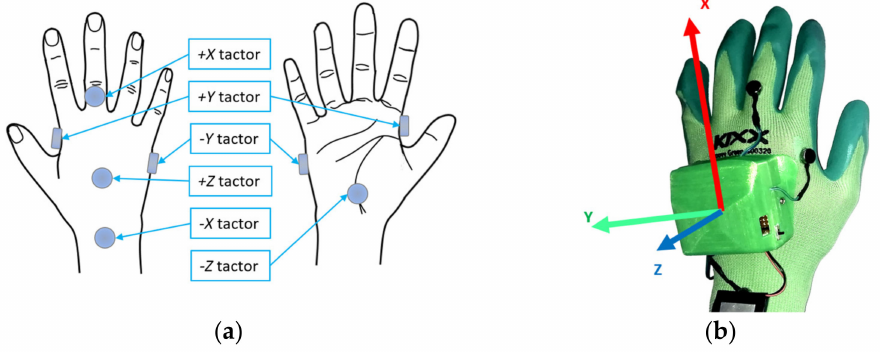
Figure 5. Tactors placement around the hand: ( a ) function of each tactor (positive and negative directions of X, Y, Z axes); ( b ) spatial organisation represents a coordinate